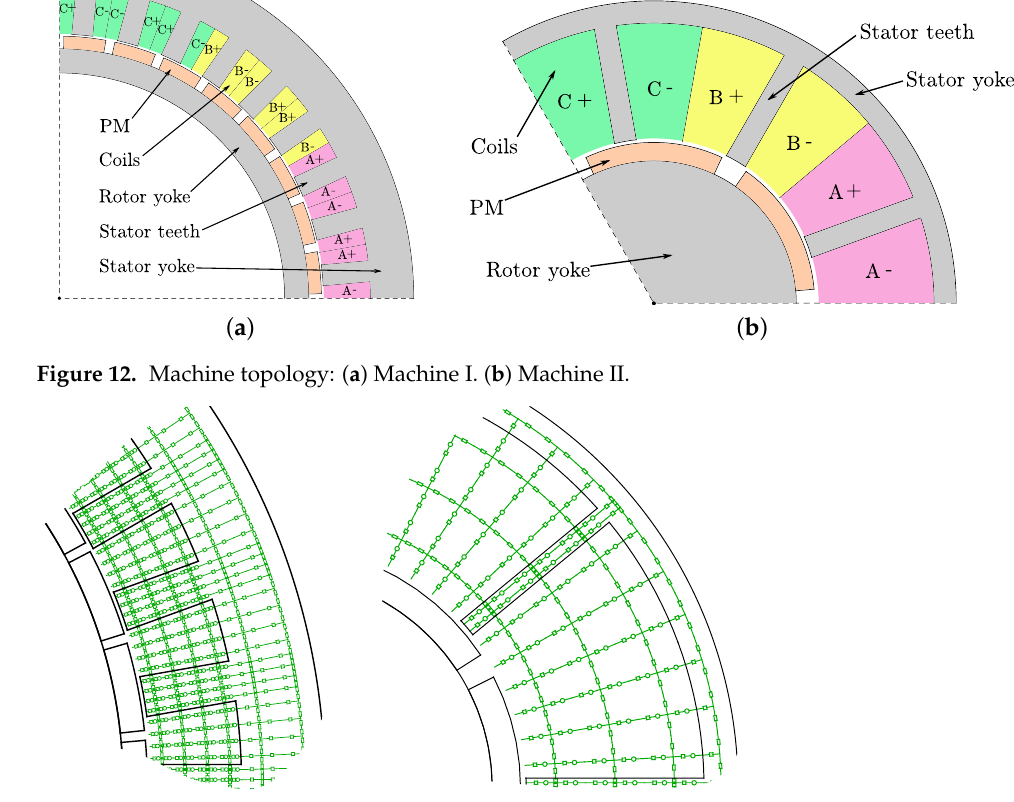
Figure 13. Example of reluctance network for ( left ) Machine I and ( right ) Machine